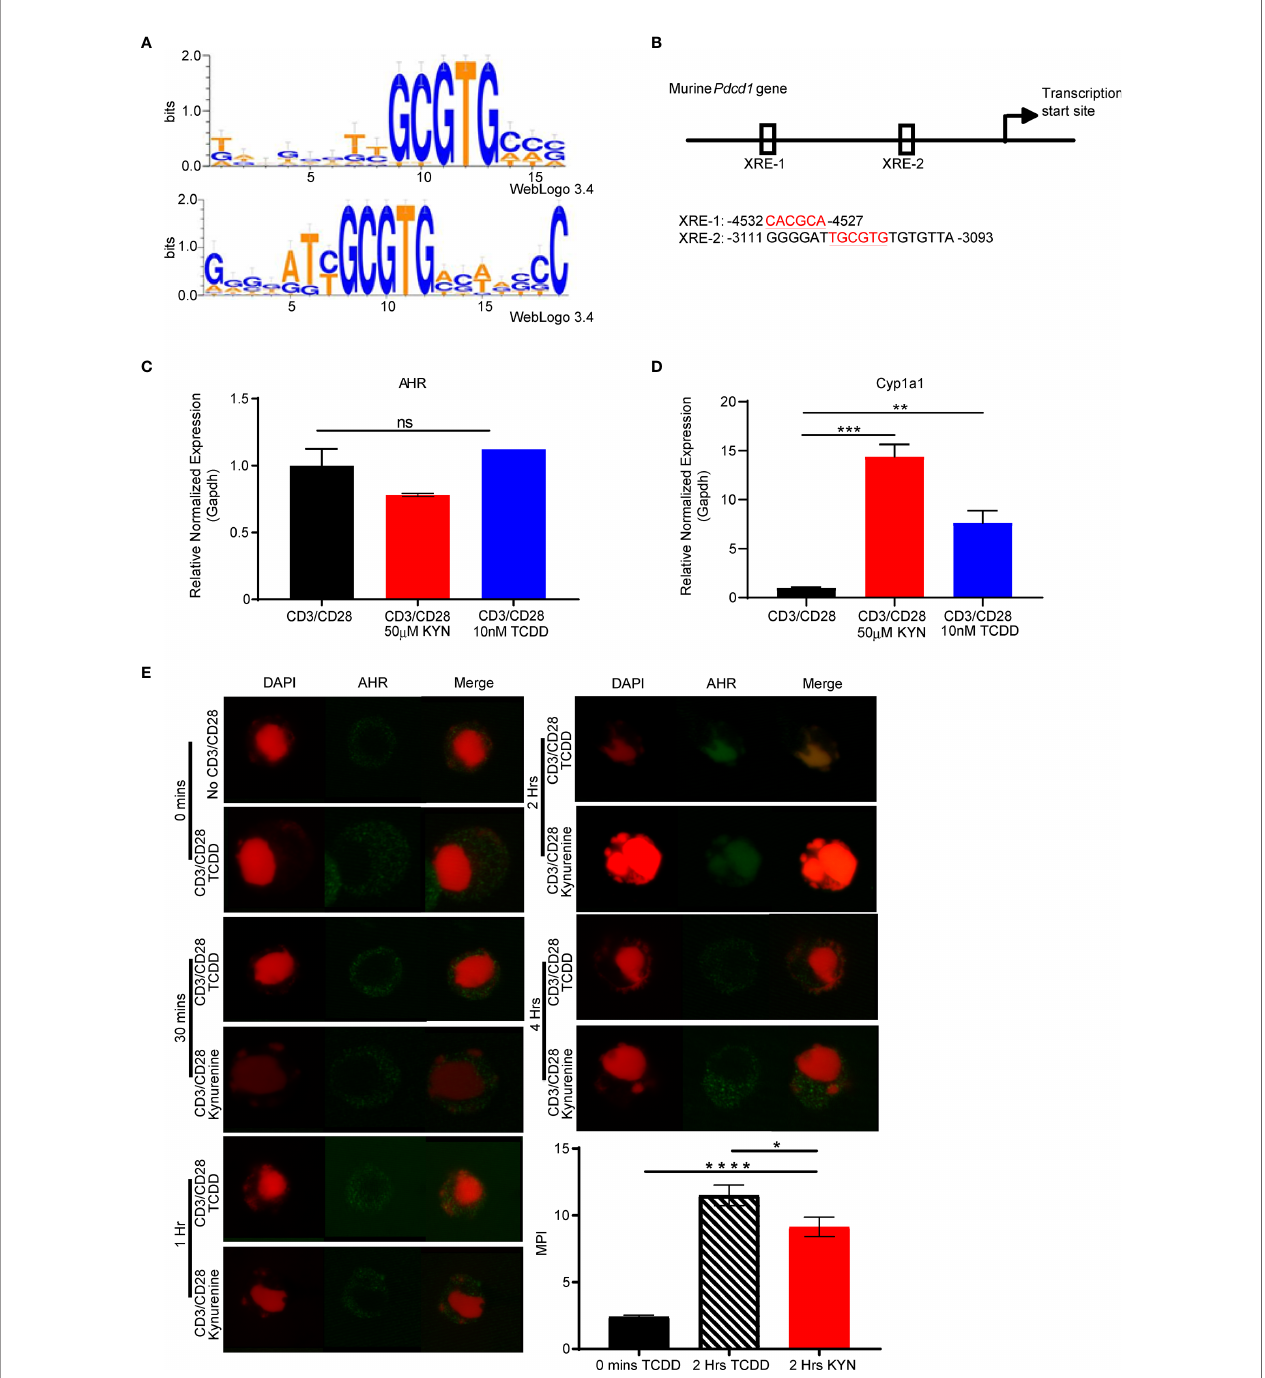
FIGURE 5 | PD-1 gene contains putative aryl hydrocarbon receptor binding sites. (A) Motif Logo depicting the position speci fi c weight matrices of the AHR binding site [xenobiotic response element (XRE)]. (B) Schematic representation of the identi fi ed AHR binding site in the Pdcd1 promoter. (C) Anti-CD3/CD28 activated CD8+ T cells from spleens of WT C57BL/6 mice were treated with IL-2 (50U/mL), KYN (50µM) or TCDD (10nM) for 6 days. AHR and (D) Cyp1a1 mRNA was determined. (E) AHR nuclear translocation was measured in anti-CD3/CD28 bead-activated CD8+ T cells from spleens of WT C57BL/6 mice treated with KYN (50µM) or TCDD (10nM) for 0,0.5,1,2 and 4hrs as indicated. CD8+ T cells were immuno-stained for AHR (green) and DAPI (red). Mean pixel intensity (MFI) of AHR nuclear translocation was calculated (bar graph) using Image J Total original magni fi cation is 189x. *p < 0.05, **p < 0.01, ***p < 0.001, ****p < 0.0001, ns, not signi fi cant, by Student ’ s t test (D, E) . The data represent means ± SEM of three independent experiments performed in